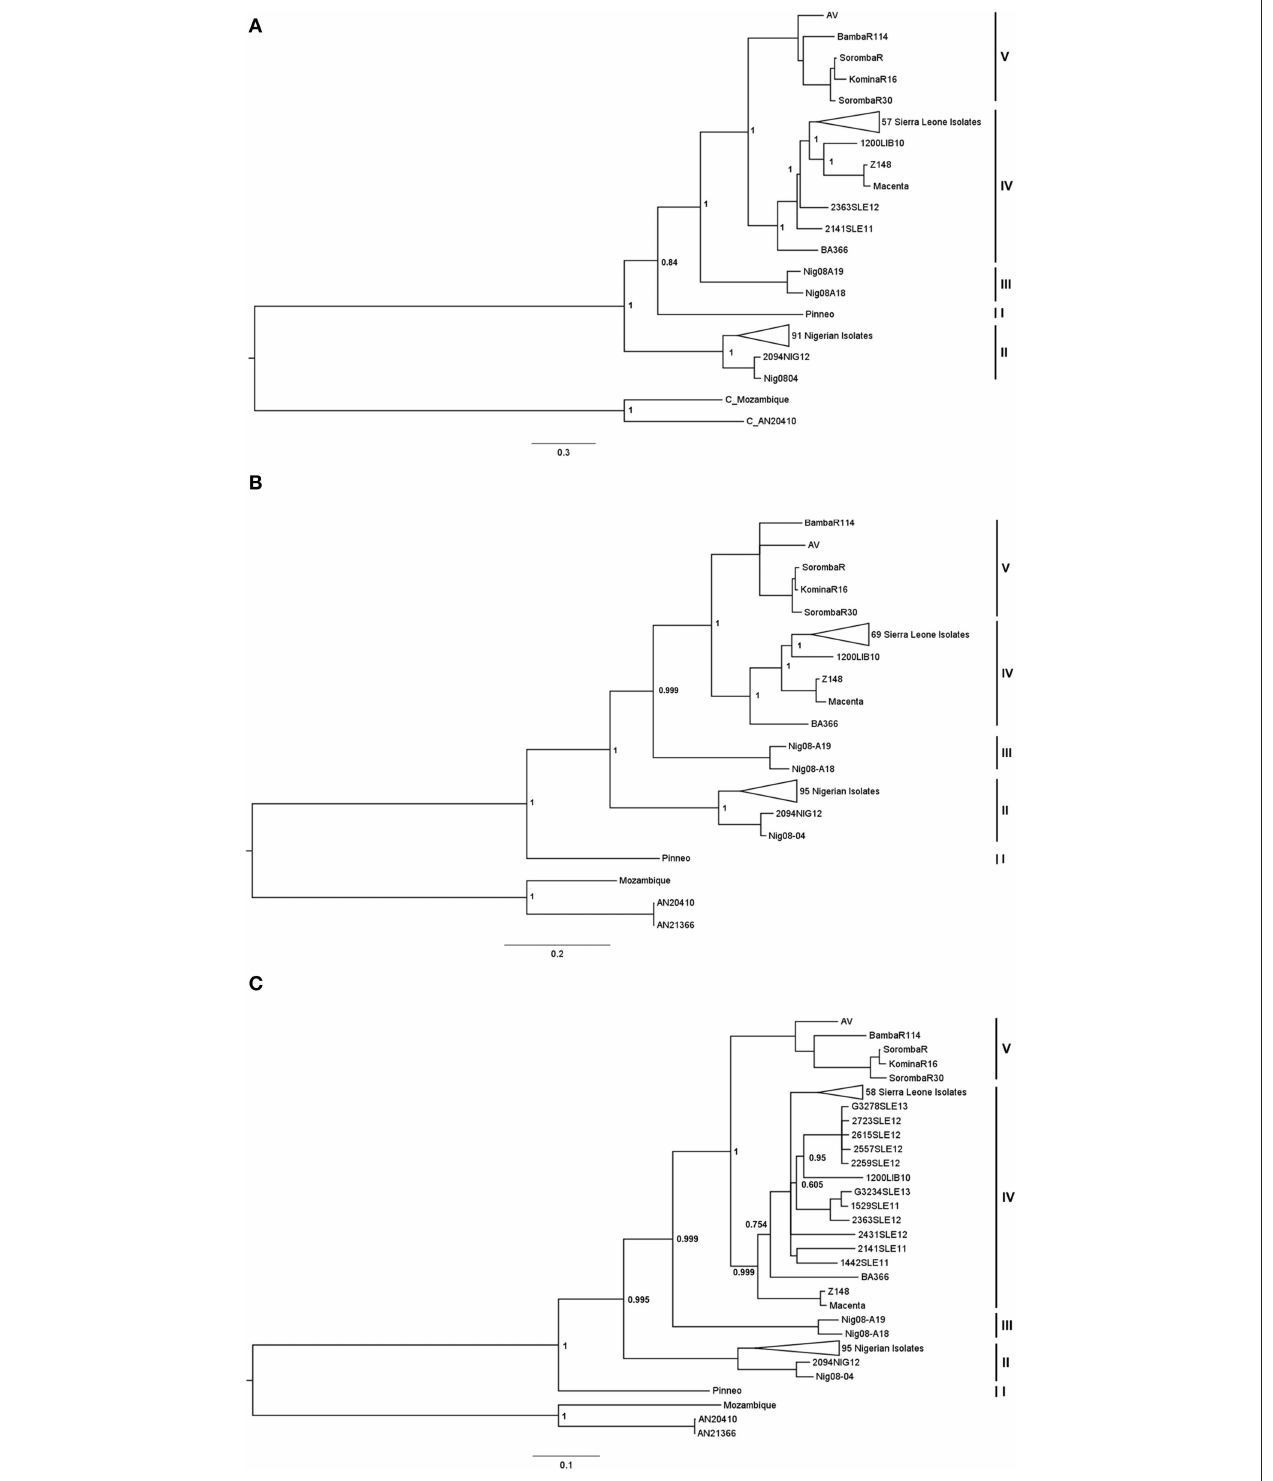
FIGURE 1 | Bayesian analysis of complete LP, NP, and GPC nucleotide sequences. Complete open reading frames were aligned using MUSCLE, and analyzed using the Bayesian MCMC approach. The resulting trees for LP (A) , NP (B) , and GPC (C) were visualized using FigTree v1.4.2 and rooted using two representative Mopeia virus isolates. To better visualize distinct lineages, several Sierra Leonian, and Nigerian isolates were collapsed. These sections of the trees are provided in Figures S1–S6. Posterior probabilities are represented as node labels for the main clades, with 1 being 100% probability. The isolates are grouped by their respective lineages, as represented by the bars to the right of the trees. The scale represents nucleotide changes per site per year.